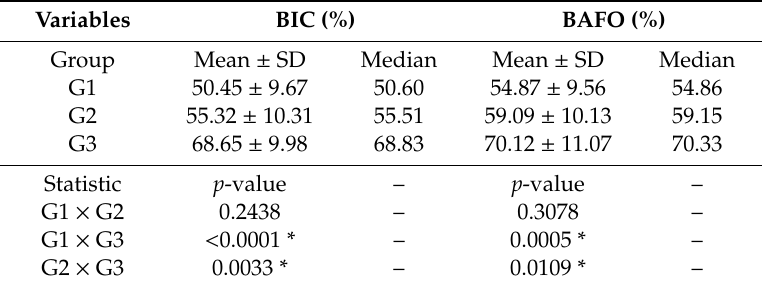
Table 2. Comparison of measured values of bone to implant contact (BIC%) and bone area fraction occupancy (BAFO%) between the three groups. The data shows the mean, SD, medians and statistical analysis values.